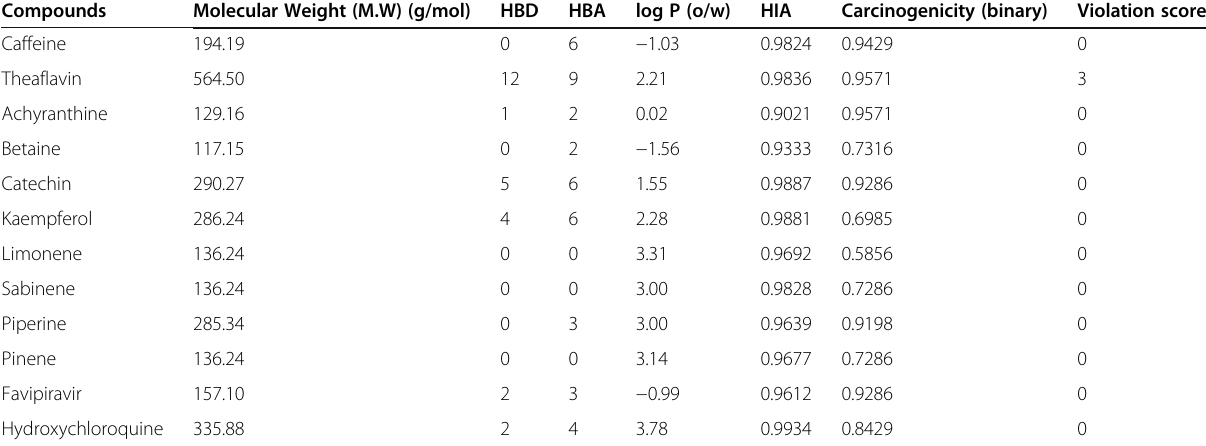
Table 3 Absorption, distribution, metabolism, excretion, and toxicological properties of the selected compounds